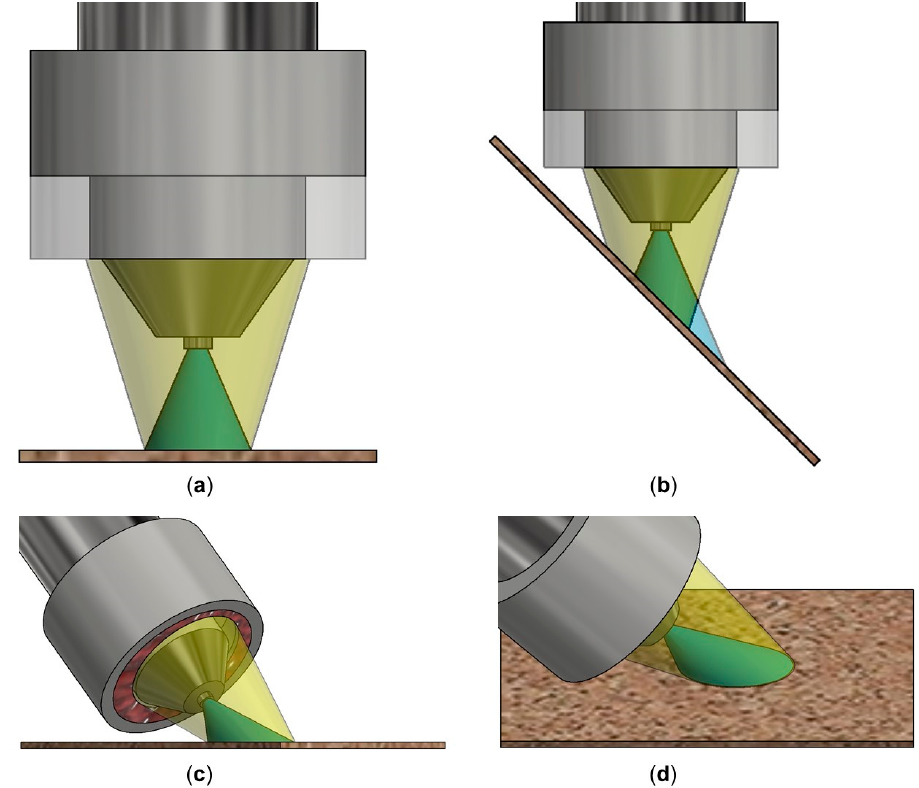
Figure 4. Concept of visualization; Illumination of treatment area using circular aperture for fixed incidence angle (aperture replaceable); ( a ) circular aperture for perpendicular (0°) and ( b ) tilted application, ( c , d ) including different perspectives using tilted device; green: estimated effective plasma zone, yellow: LED-illuminated zone.